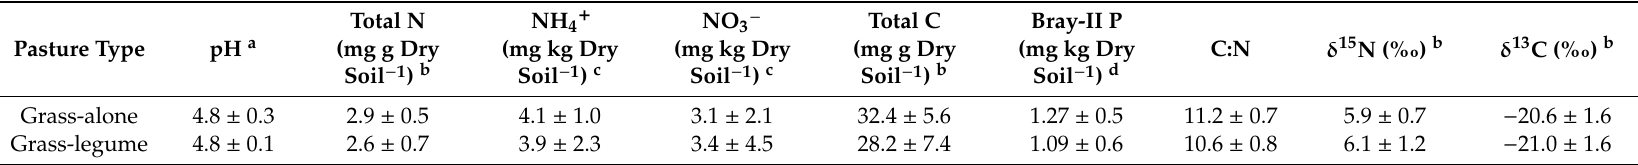
Table 1. Soil chemical characteristics (0–10 cm soil depth) of grass-alone and grass-legume pastures sampled on farms in the Caquet á Department of Colombia. Each value represents the mean of ten plots for grass-alone, and of eight plots for grass-legume pastures.